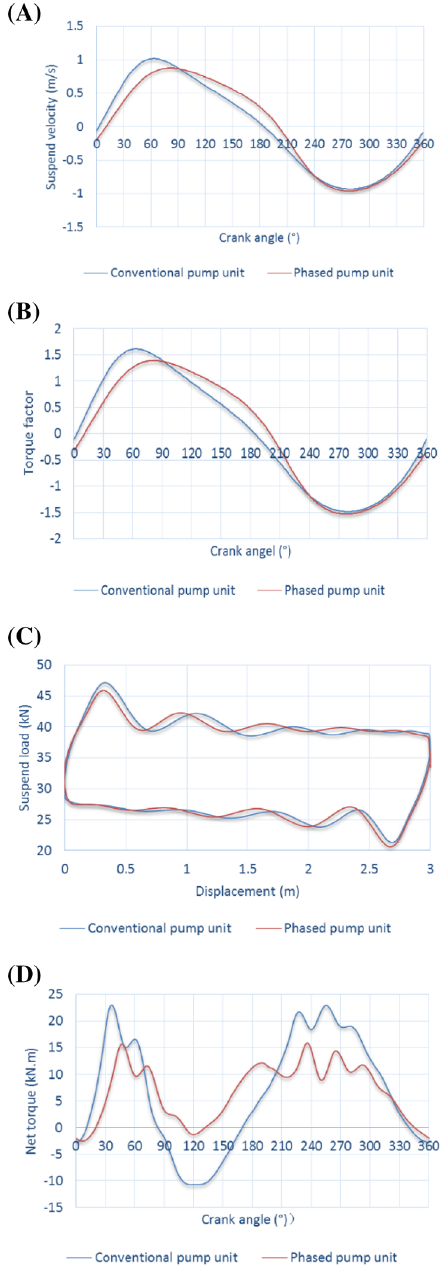
Fig. 8 Characteristic comparison between conventional pump units and phased pump units (Feng et al. 2016). a Suspend velocity, b torque factor, c polished rod indicator diagram, d net